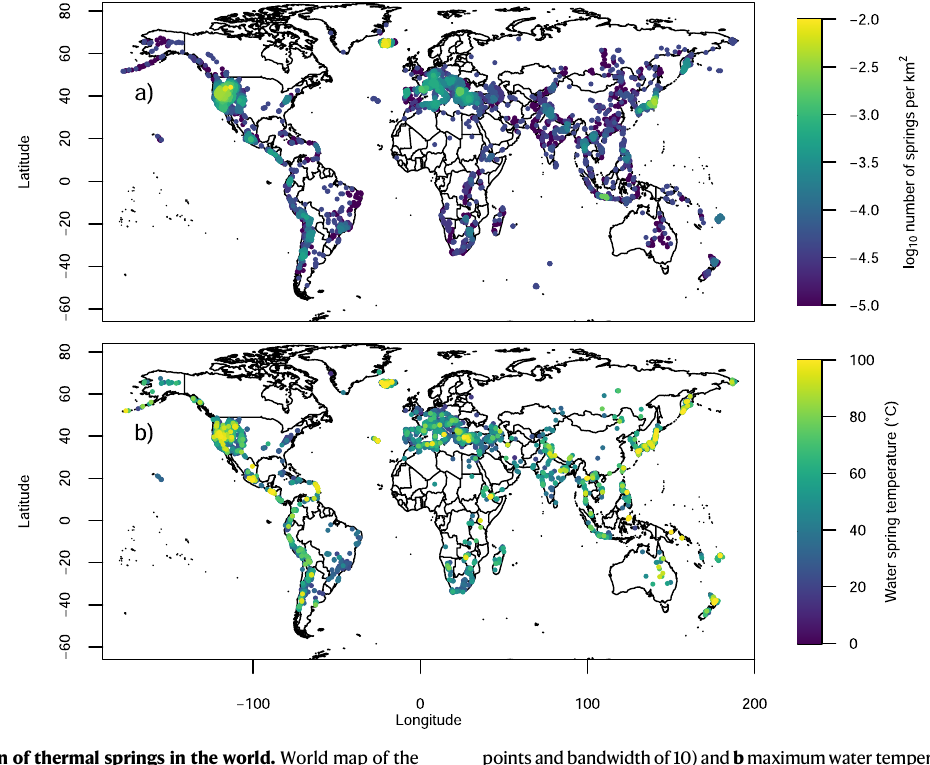
pointsandbandwidthof10)and b maximumwatertemperatureinCelsiusdegreeif provided by Waring 13 (map created with maps 50 R